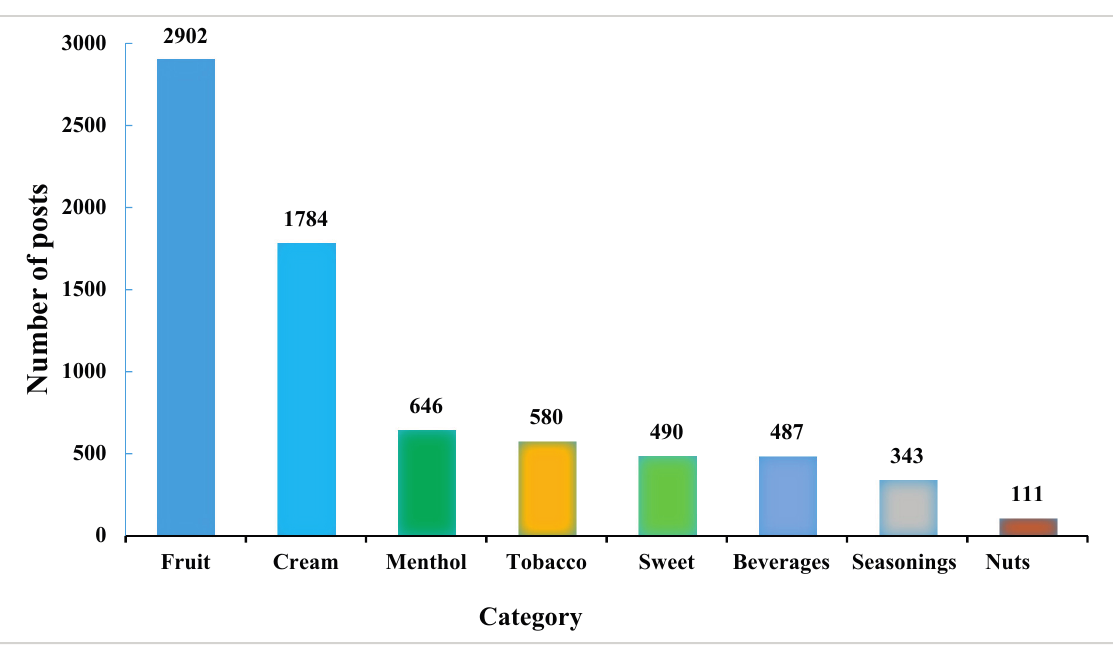
Figure 1. Flavor frequencies from multi-flavor